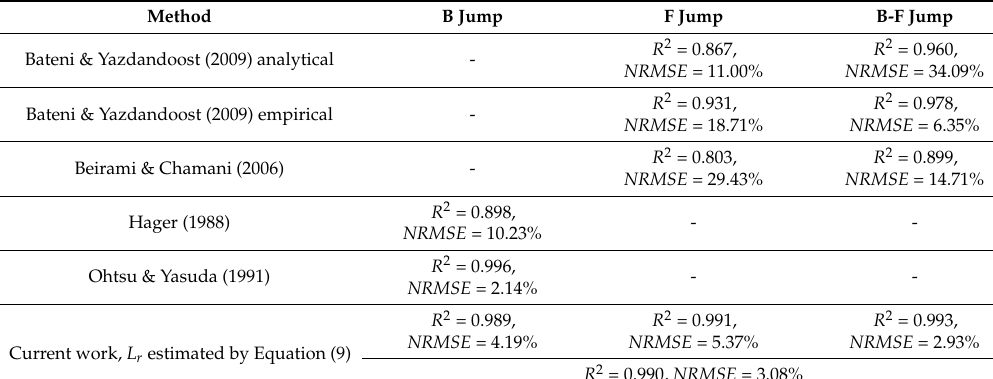
Table 1. Summary of results for different methods for estimation of sequent depth h 2 .